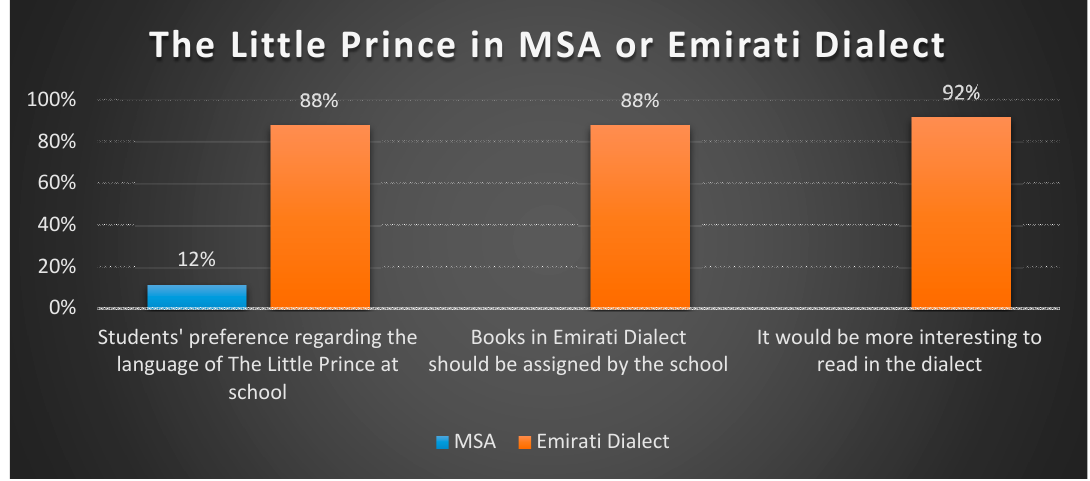
Figure 6. The Little Prince in MSA or Emirati Dialect.